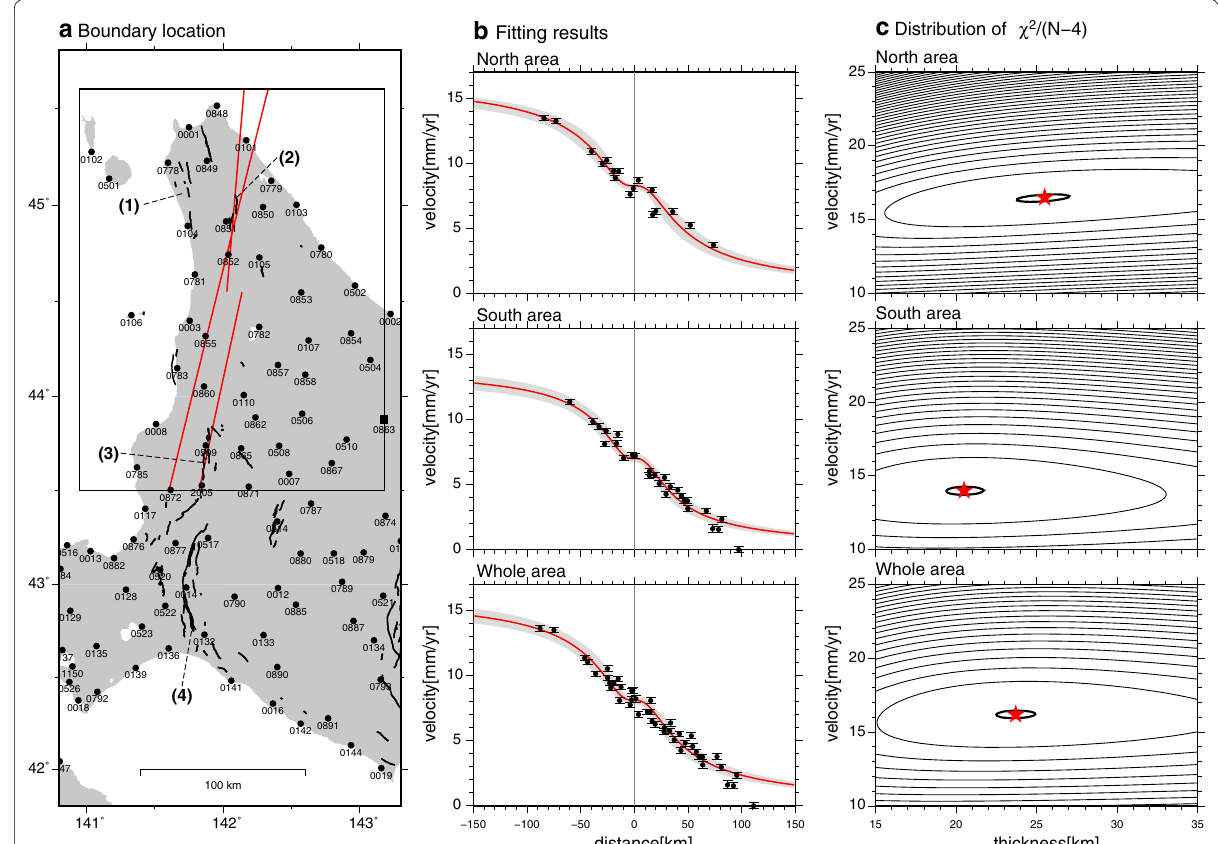
Fig. 3 a Locations of GEONET stations used in this study. Red lines in the northern, southern, and whole areas are the estimated boundaries in each area of analysis. Active faults (Nakata and Imaizumi 2002) are shown by black lines; (1) Sarobetsu, (2) Toikanbetsu, (3) Mashike-Toen, (4) Ishikari-Teichi-Toen faults. b Velocity profiles of three respective area plotted against the distance from the boundary. The red curves and black dots are the theoretical best fit functions and the observed velocities with 2 σ errors, respectively. The gray shaded areas represent the range of 2 σ model errors. c Distribution of χ 2 /( N − 4 ) value with varying convergence velocity and elastic thickness of three areas with the best fit boundary location and strike. Red stars show the least error domain. The bold black lines indicate a confidence interval of 95%. The gray lines are drawn at regular intervals of 100 units